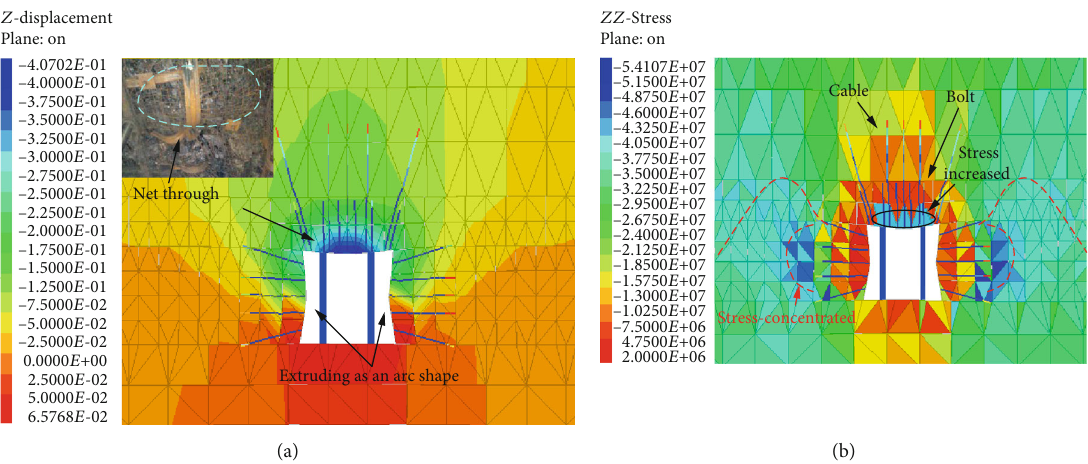
Figure 6: Numerical simulation results of the surrounding rock deformation at 35 m in front of the coalface: (a) cloud graph of vertical displacement; (b) cloud graph of vertical